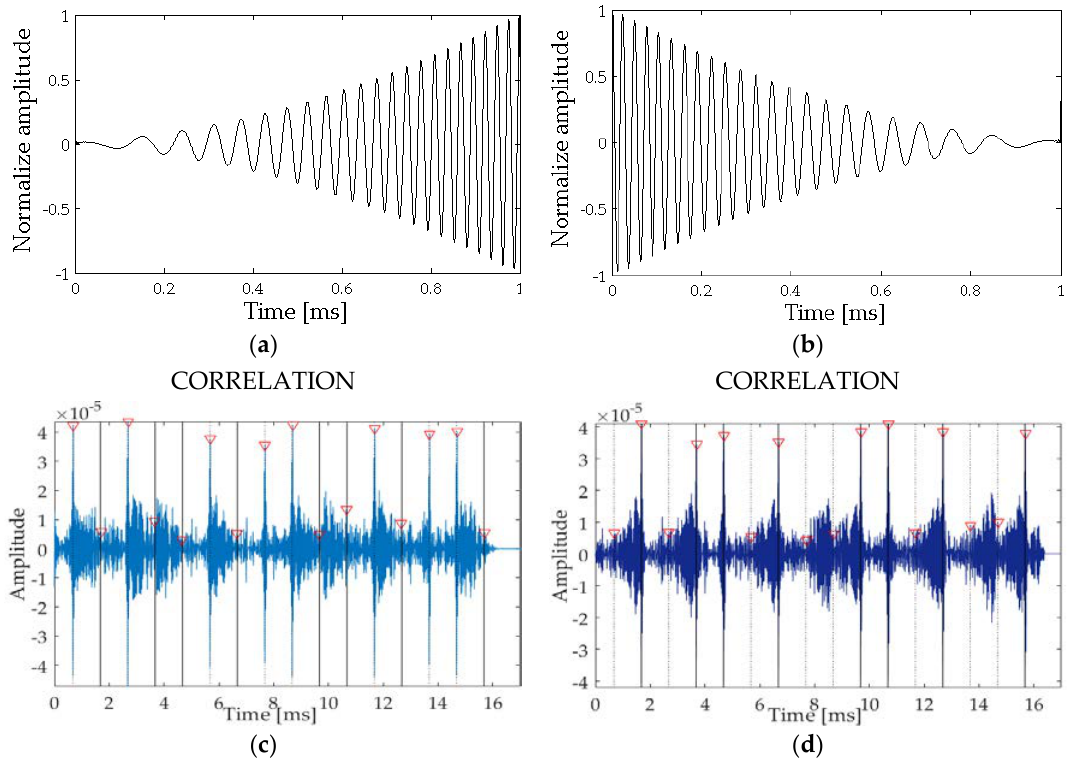
Figure 4. Signal analysis using cross-correlation. ( a ) second time derivative of envelope for bit 1; ( b ) second time derivative of envelope for bit 0; ( c ) Cross correlation signal with bit 1; ( d ) Cross correlation signal with bit 0.